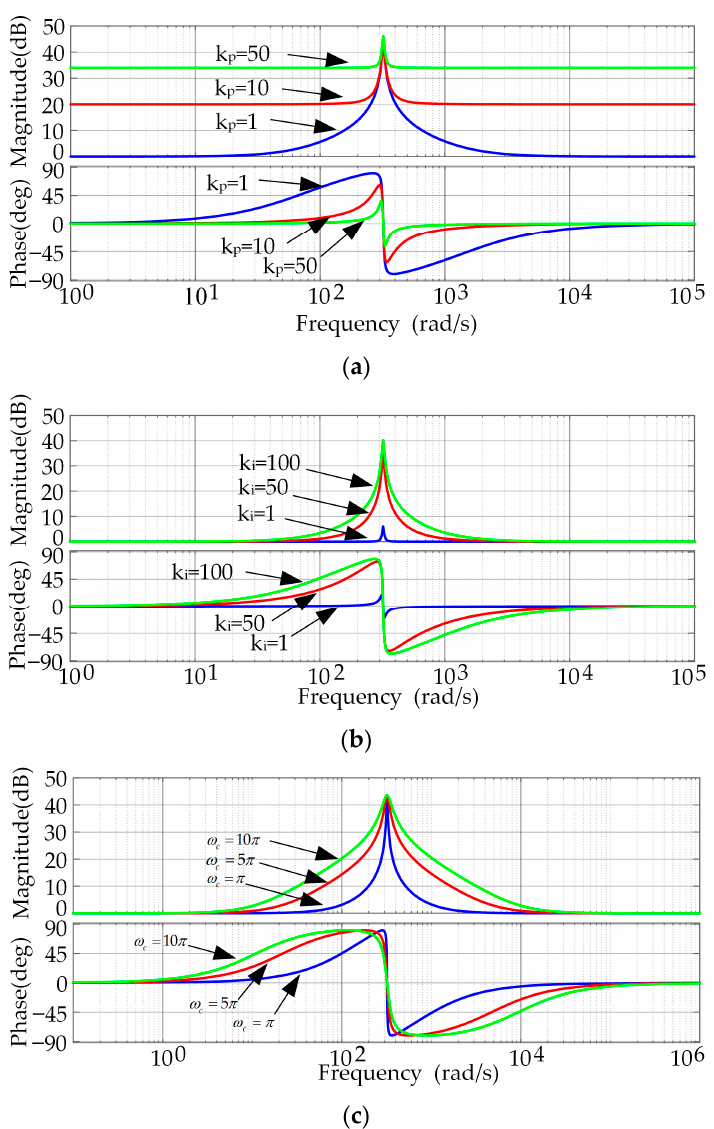
Figure 3. Bode diagram of QPR when k p , k i , and ω c change. ( a ) k p change; ( b ) k i change; ( c ) ω c